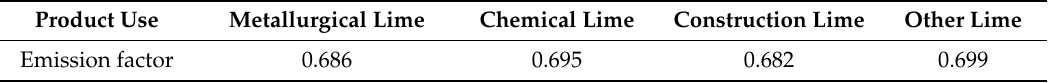
Table 1. Lime industrial process emission factors (t CO 2 /t lime) in China